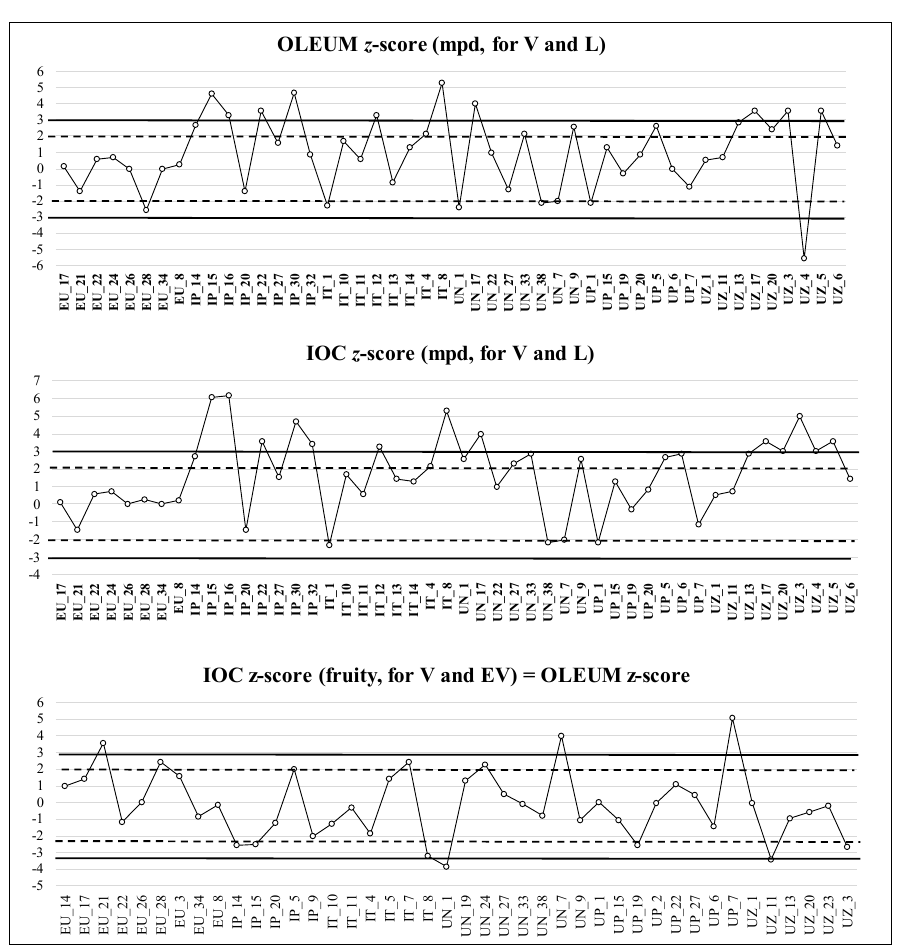
Figure 4. Example of z-score graph for estimation of panel performance, calculated on 60 samples from the subgroup of the first sampling year (180 samples). Criteria of acceptance: | z | ≤ 2, performance was satisfactory; 2 < | z | ≤ 3, performance was questionable; | z | > 3, performance was considered unsatisfactory. The z-scores were calculated for median of the main perceived defect (for V and L category) and for the median of fruity attribute (for V and EV category).